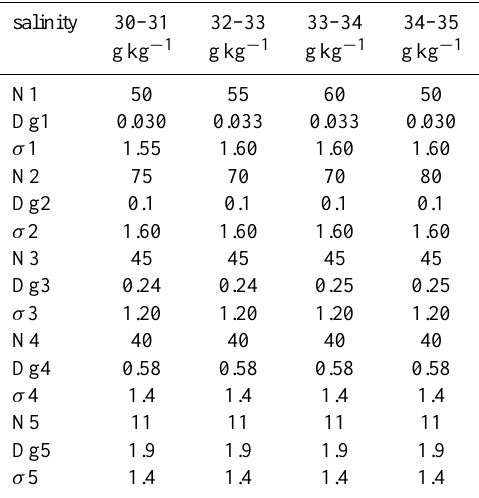
Table 3. Parameters for fitted lognormal aerosol number size dis- tributions with Nx as the number concentration (cm − 3 ), Dgx as the geometric diameter (µm) and σ x as the standard deviation for the different modes and salinities: 30–31gkg − 1 , 32–33gkg − 1 , 33– 34gkg − 1 , and 34–35gkg − 1 .